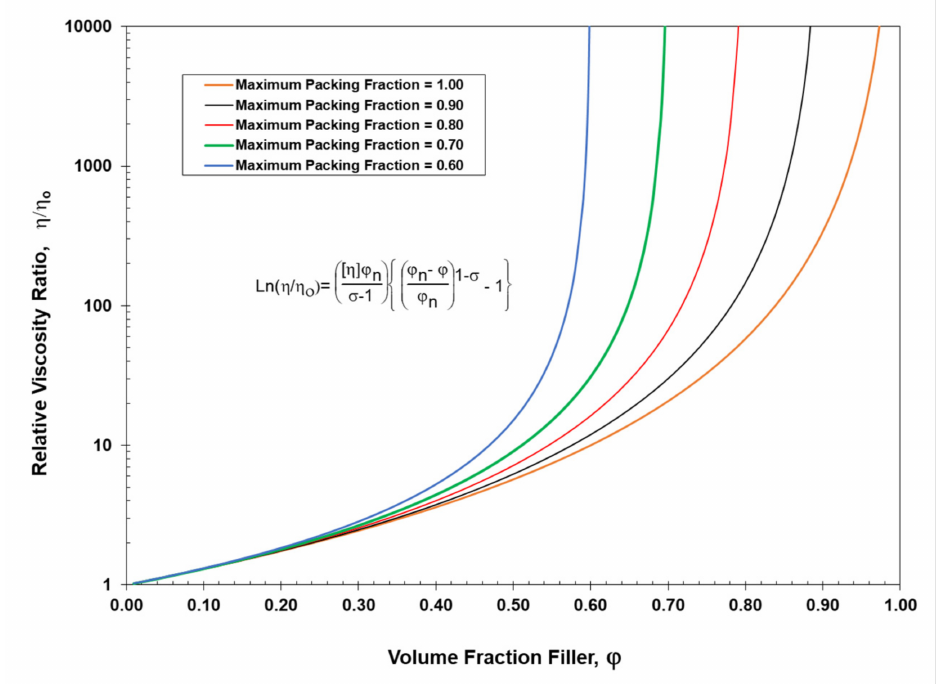
Figure 7. General viscosity model vs. volume fraction filler for a range of maximum packing fractions. ([ η ] = 2.5 and σ =